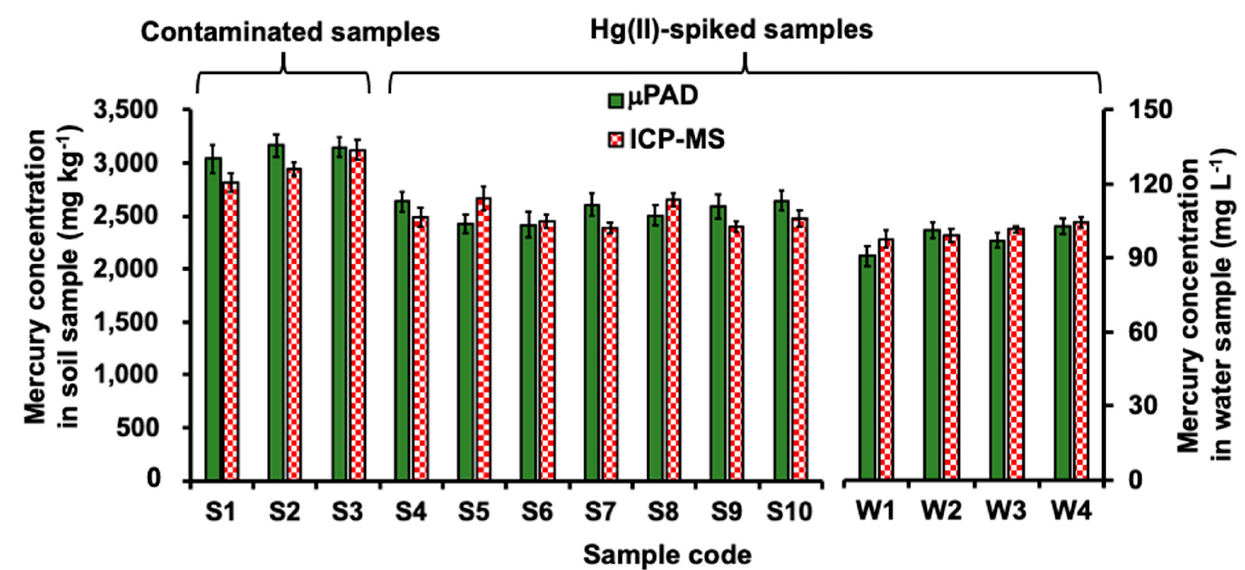
Figure 6. Bar plots of the concentrations of mercury in digested soil and water samples as determined using the membraneless gas-separation µ PAD and the reference ICP-MS method. The digested soil samples, S1–S3, were analyzed directly using ICP-MS with appropriate dilution. The other digested soil samples, S4–S10, were spiked at 2500 mg kg − 1 Hg. The water samples, W1–W4, were spiked at 100 mg L − 1 Hg.